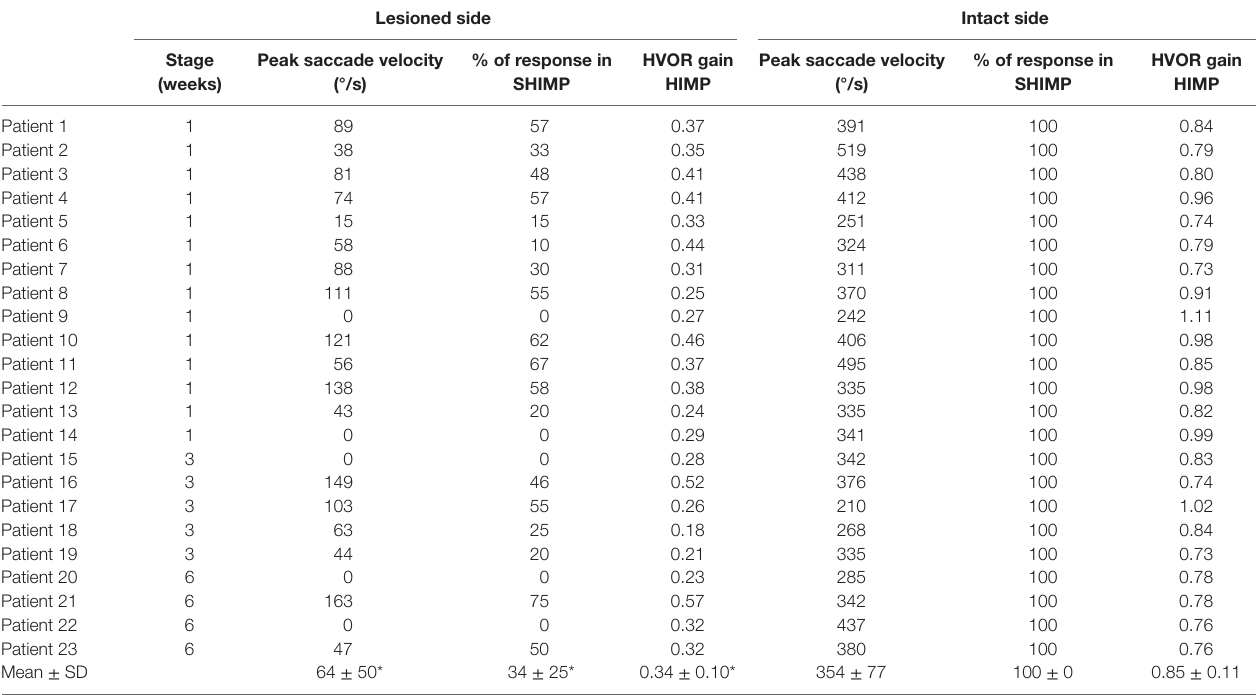
lesioned side intact side